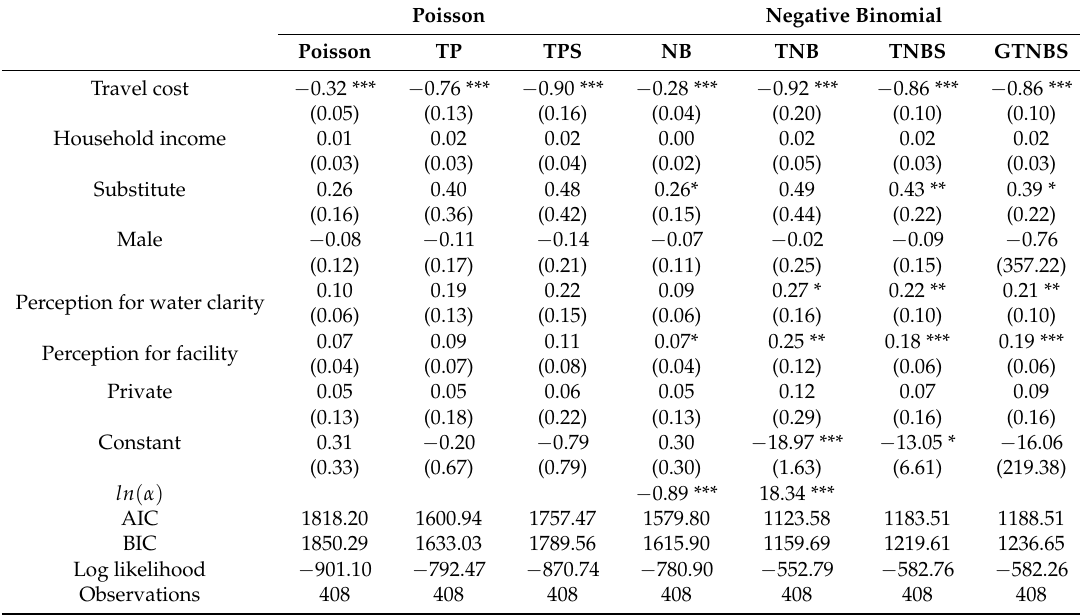
Table 3. Estimated results of the travel cost